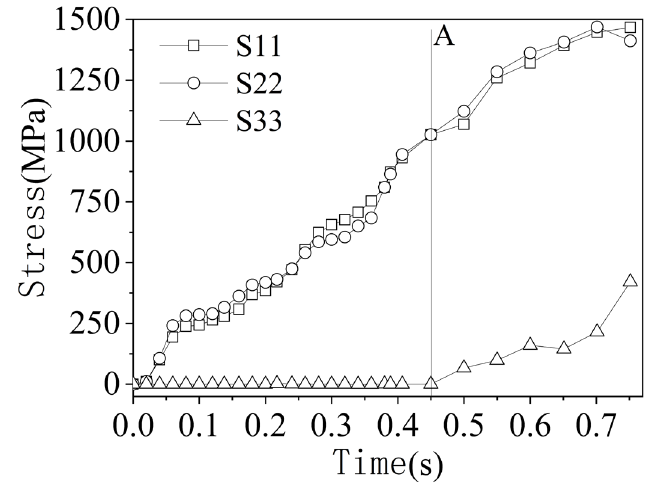
Figure 4. Schematic diagram of the stress change at the necking point.